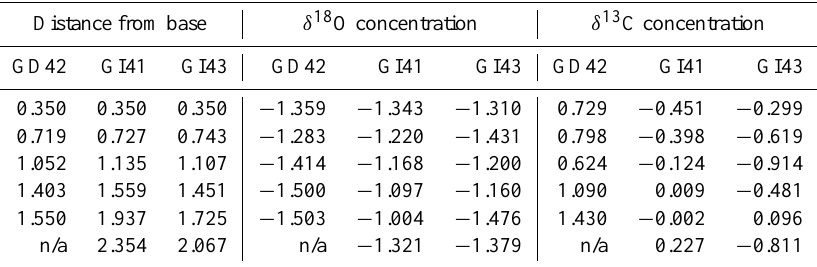
Table 1. Distance from paries’ base, oxygen isotope ratio and carbon isotope ratio in Platylepas sp. barnacles collected from three green sea turtles (GD42, GI41, and GI43) in Palmyra Atoll National Wildlife Refuge. Rows show the average of three barnacles per turtle sampled. Distance is given in millimeters and isotope ratios are reported versus the VPDB scale. Distance from base δ 18 O concentration δ 13 C concentration GD42 GI41 GI43 GD42 GI41 GI43 GD42 GI41 GI43 0.350 0.350 0.350 − 1.359 − 1.343 − 1.310 0.729 − 0.451 − 0.299 0.719